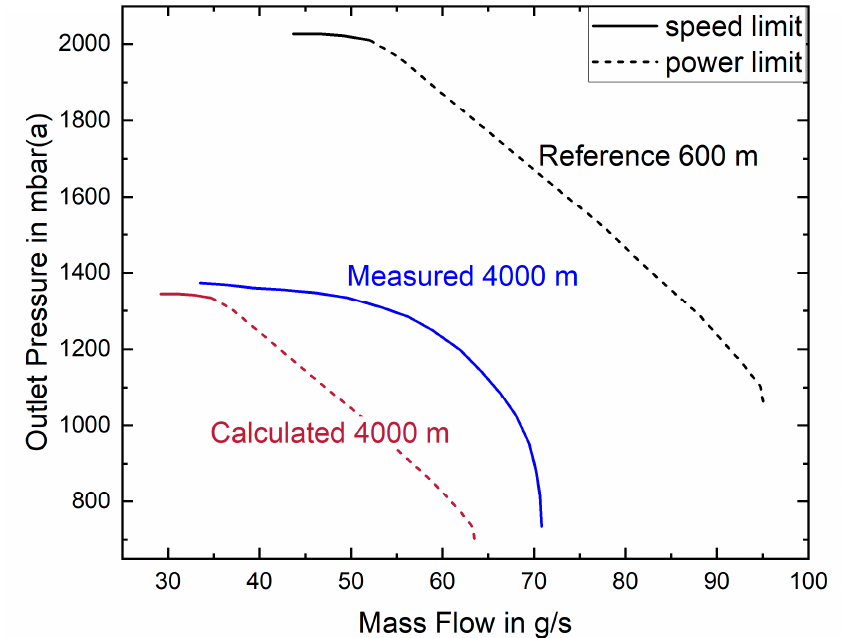
Figure 8. Measured compressor limit at 600 m and calculated corresponding limit at 4000 m, in comparison to the measured compressor limit for a 4000 m altitude for the Fischer 150k compressor. Speed limit is plotted in the solid line and the power limit is plotted in dashed lines.